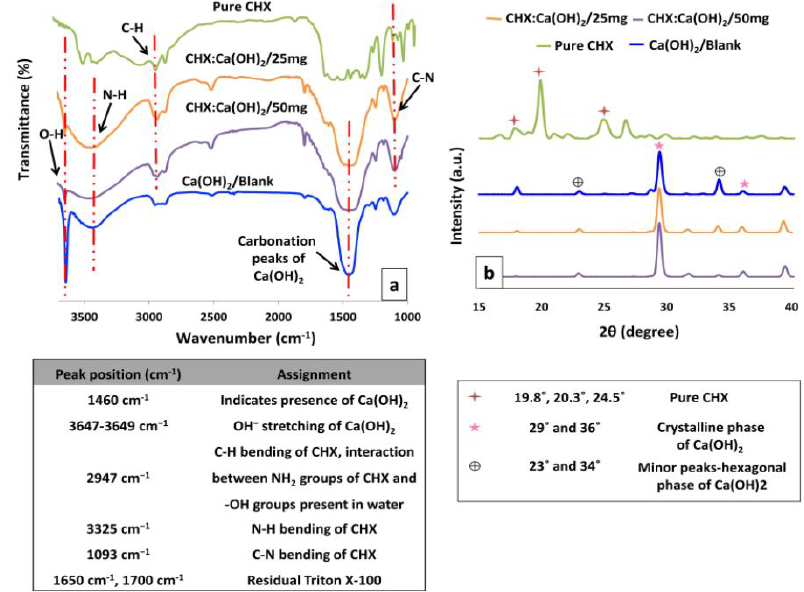
Figure 4. ( a ) Representative FTIR showing the vibrational-bands obtained for the pure Chlorhexidine (CHX), the Ca(OH) 2 /Blank microparticles and the CHX-loaded/Ca(OH) 2 microparticles at the formulations of CHX:Ca(OH) 2 /25 mg and CHX:Ca(OH) 2 /50 mg respectively. The FTIR data confirms the evidence of CHX inclusion in the CHX-loaded/Ca(OH) 2 microparticles. The vibrational-bands observed at 1460 cm − 1 confirms the presence of Ca(OH) 2 and the presence of peak at 3647–3649 cm − 1 attribute to OH − stretching of the solid Ca(OH) 2 crystals in all formulations of CHX-loaded/Ca(OH) 2 microparticles. The fingerprint peaks specific to CHX shows characteristic peaks at 2947 cm − 1 , 3325 cm − 1 and 1093 cm − 1 for C–H, N–H and C–N respectively, observed in both formulations of CHX-loaded/Ca(OH) 2 . The interaction between the amine (–NH 2 ) groups in CHX and the hydroxyl (–OH) groups present in Ca(OH) 2 has resulted in the binding of CHX to the Ca(OH) 2 carrier. Accordingly, the N-H bend (3325 cm − 1 ) was notably flatter/wider and C–N peak (1093 cm − 1 ) became deeper upon CHX inclusion. The positions of the FTIR peak frequencies and their corresponding assignment in the Ca(OH) 2 /Blank, pure Chlorhexidine (CHX) and CHX-loaded/Ca(OH) 2 microparticles at formulations of CHX:Ca(OH) 2 /25 mg and CHX:Ca(OH) 2 /50 mg respectively have been indicated in the table (left) . ( b ) Representative X-ray diffractograms (XRD) of pure Chlorhexidine (CHX), the Ca(OH) 2 /Blank microparticles, and the CHX-loaded/Ca(OH) 2 microparticles at the formulations of CHX:Ca(OH) 2 /25 mg and CHX:Ca(OH) 2 /50 mg are displayed respectively. The typical XRD peaks of Ca(OH) 2 present the diffraction angles at 29 ◦ and 36 ◦ indicating the crystalline phase of Ca(OH) 2 in the all formulations. Pure CHX showed clear peaks at 2 θ of 19.8 ◦ , 20.3 ◦ and 24.5 ◦ and the absence of these characteristic peaks in the CHX-loaded/Ca(OH) 2 formulations confirmed uniform CHX dispersion in the structure of the CHX-loaded/Ca(OH) 2 microparticles. The positions of the XRD peaks and their corresponding assignment in the Ca(OH) 2 /Blank microparticles, pure Chlorhexidine (CHX), CHX-loaded/Ca(OH) 2 microparticles have been indicated in the table (right) .